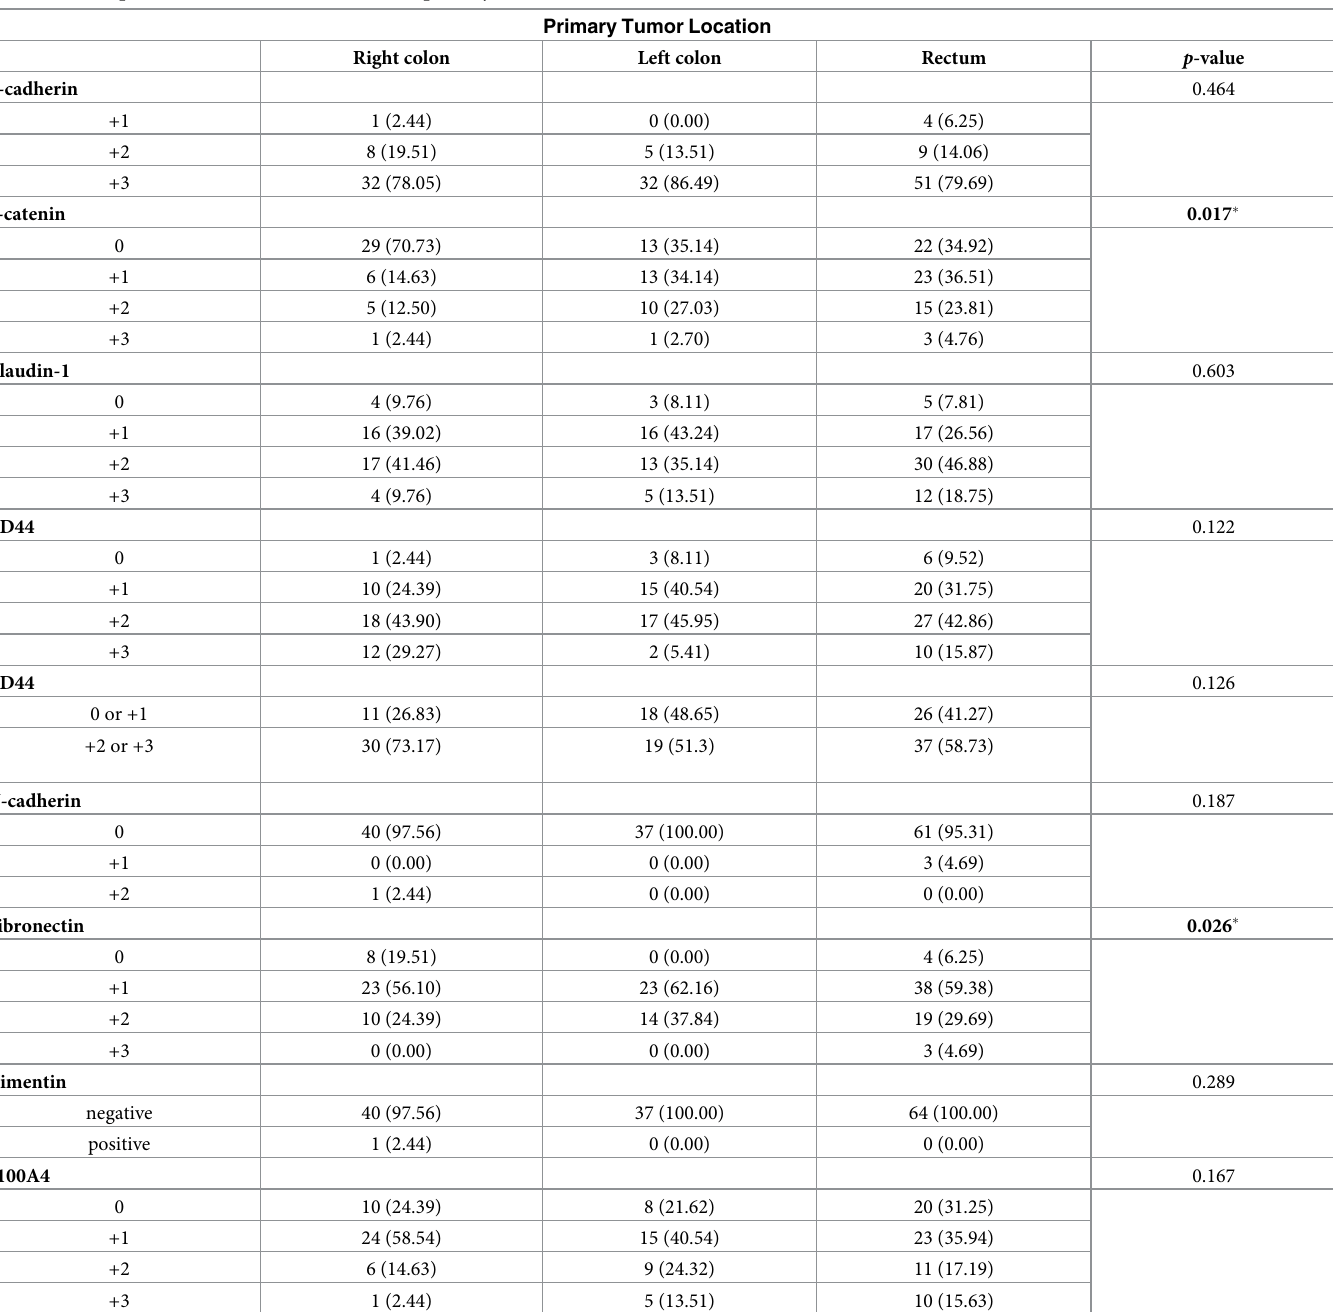
Table 9. IHC expression of EMT-related markers vs . primary tumor